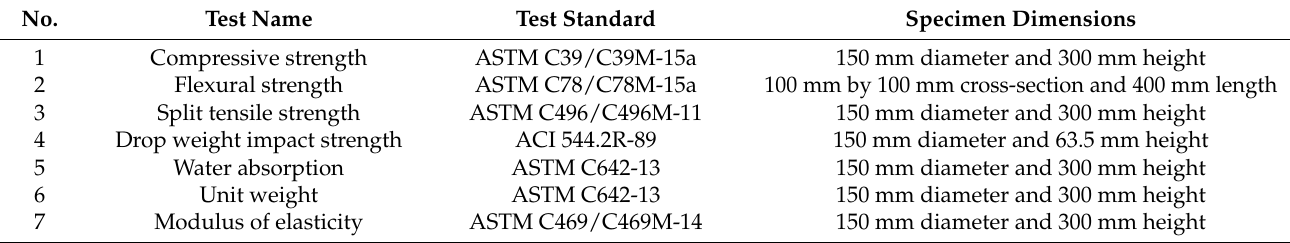
Table 6. Specimen dimensions for different